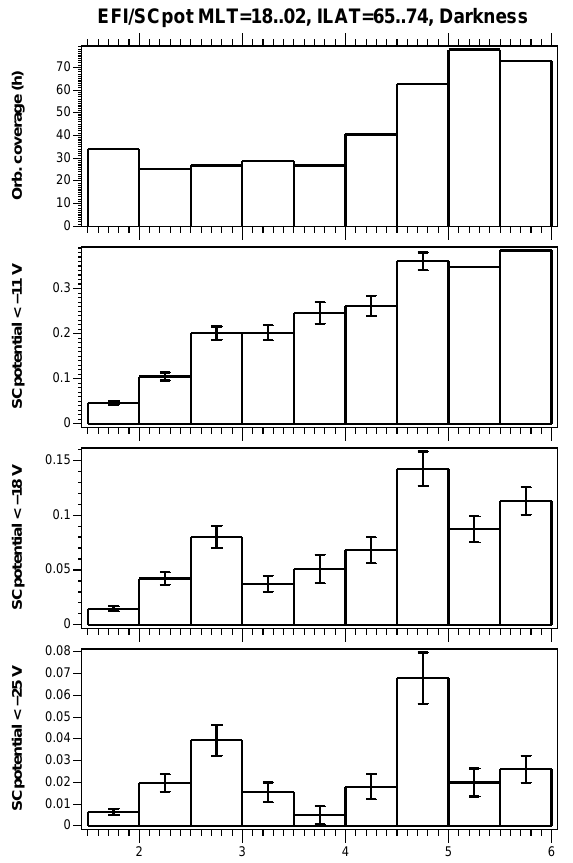
Fig. 11. The cavity occurrence frequency for K p > 2 (i.e. times when substorms are common) in the evening and midnight sectors (18:00–02:00MLT) for three different spacecraft potential thresh- olds using Polar/EFI data (three lower panels), and the orbital cov- erage (top panel) when the ionospheric footpoint is not illuminated by Sun. The interesting double-peaked structure emerges as the spacecraft potential threshold is made more negative: it is most vis- ible in the bottom panel. The occurrence frequency is the fraction of time the given condition is fulfilled; it is thus a number between 0 and 1. For more details, see Janhunen et al.,